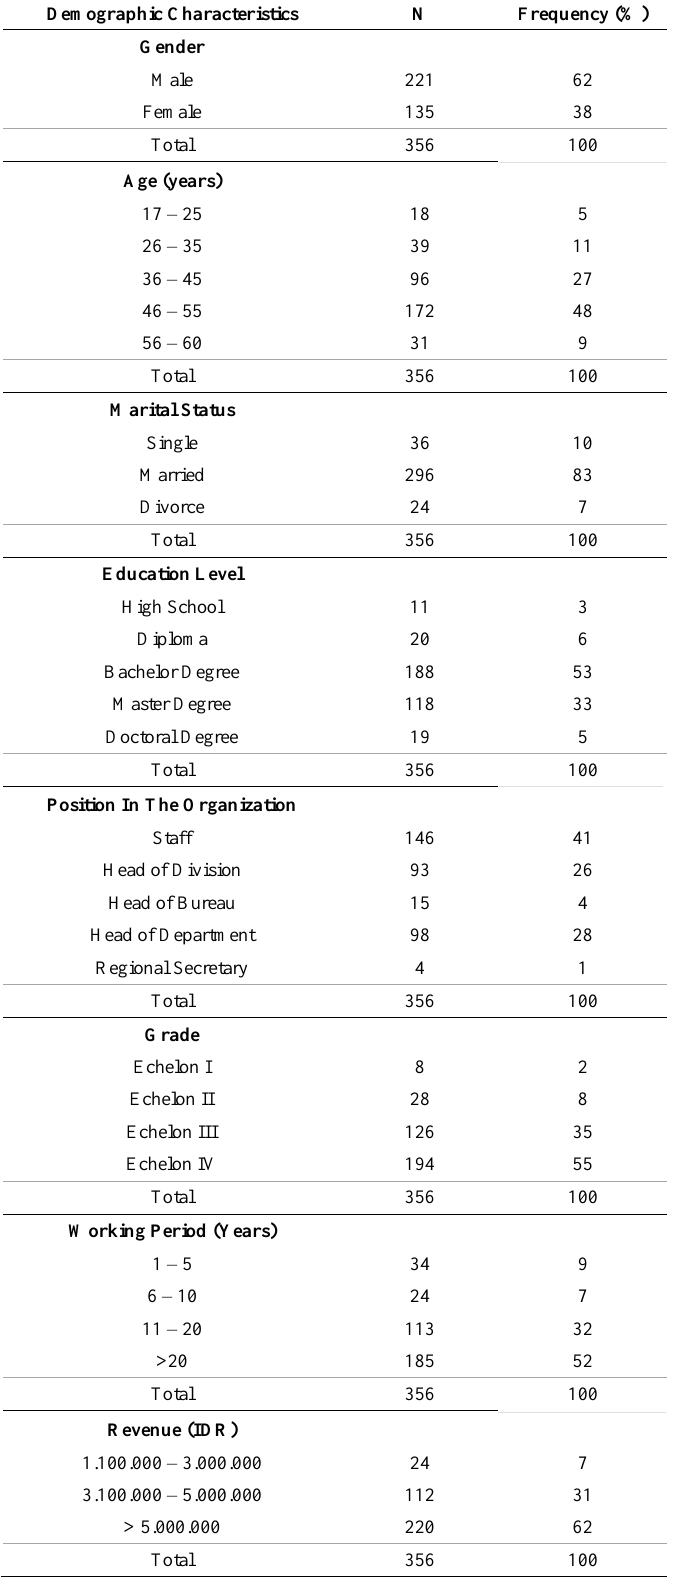
Table 1. Characteristics of